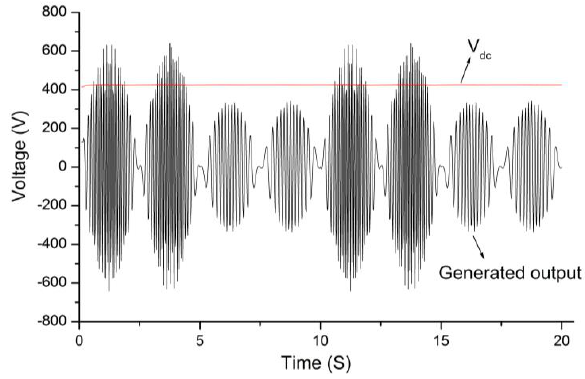
Figure 13. Output voltages of LWEC for four wave cycles.